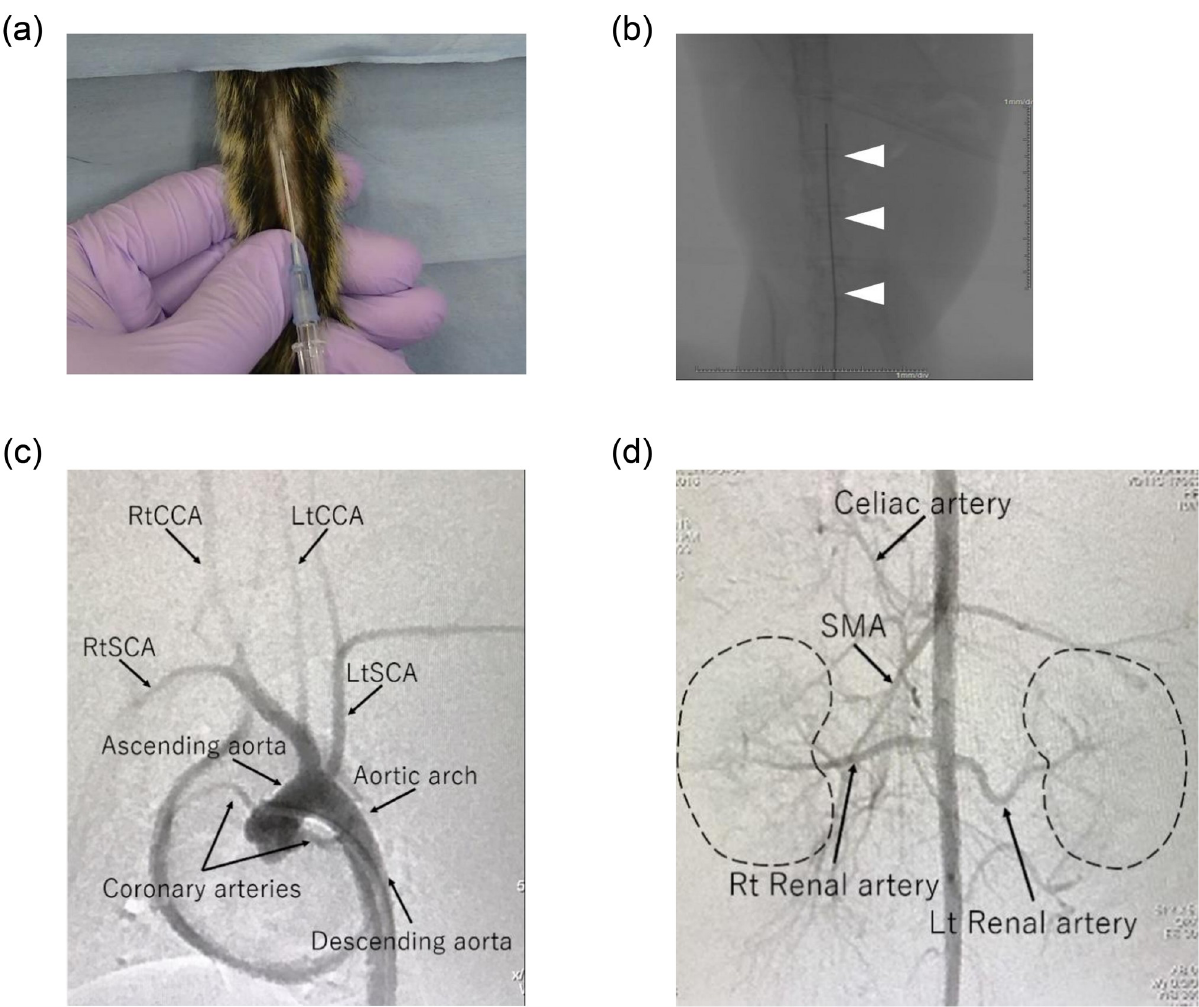
Fig 1. The most minimally invasive aortic approach. (a) Puncture of caudal ventral artery (CVA) in marmosets. A sheath was inserted through the ventral midline, approximately 5 cm from the root of the tail of the marmoset, at a sharp angle after tail shaving. (b) Marmoset fluoroscopic images of the wire inserted carefully through the sheath inserted into the CVA and guided into the abdominal aorta. If the wire is lost in the abdominal visceral branch, it can be withdrawn immediately because it can be confirmed in real time by the fluoroscope. (c,d) A contrast agent was injected into a microcatheter indwelling in the arch/abdominal aorta, and arch/abdominal angiography was performed. There were individual differences in the position and direction of the branch of visceral arteries. Detailed vascular information was obtained in the aortic arch (c) and abdominal aorta (d) of